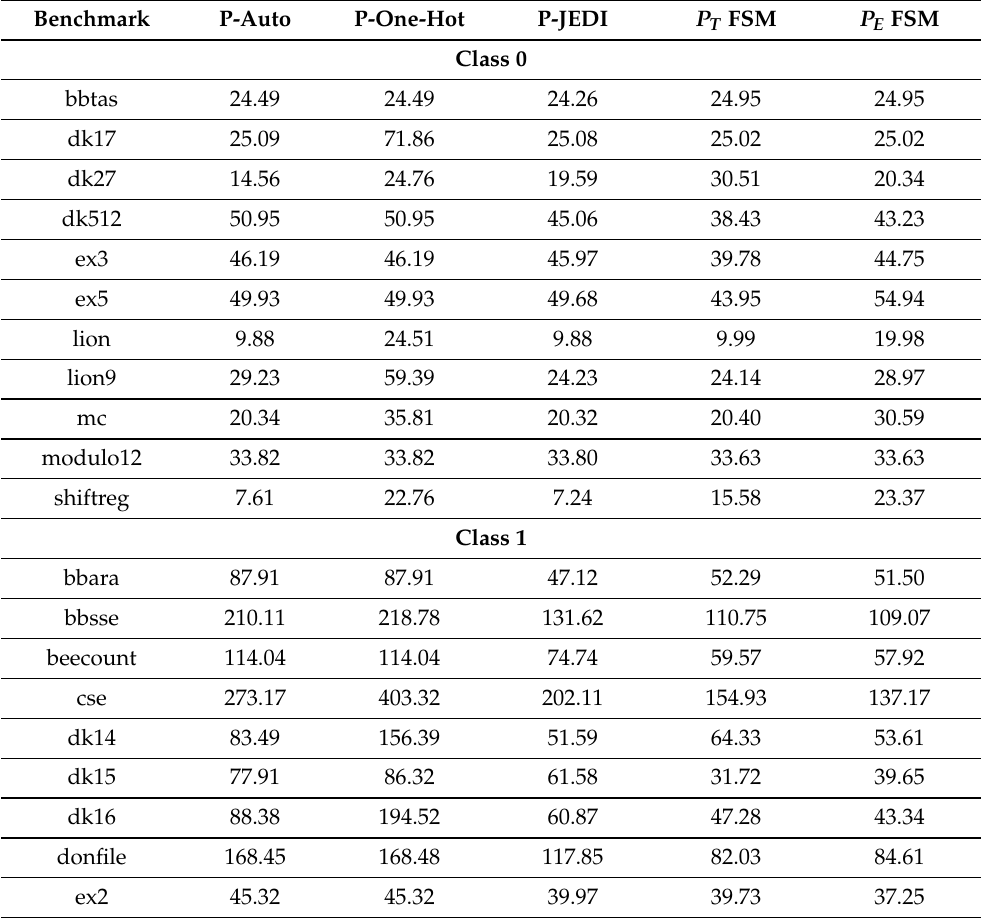
Table 11. Experimental results (products of LUT counts by propagation